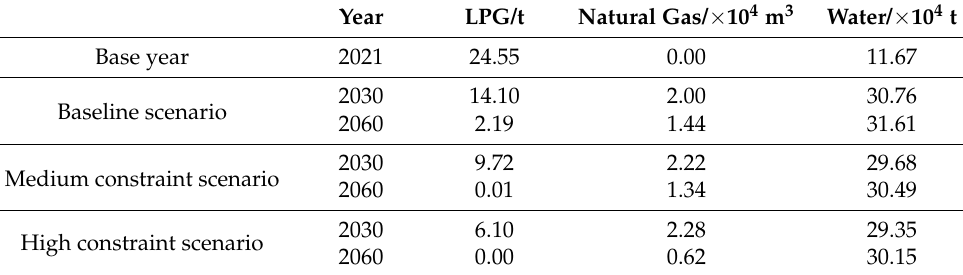
Table 5. Other energy forecasts for buildings in village